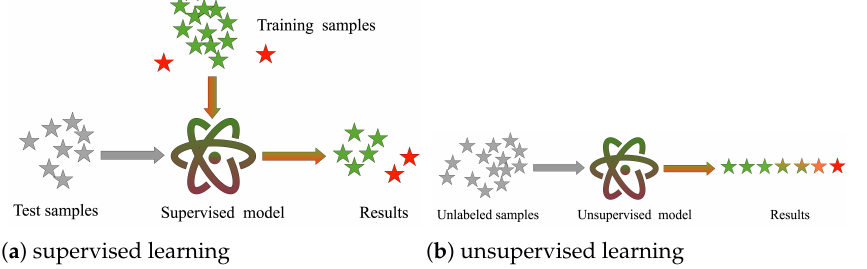
Figure 1. Machine learning algorithm